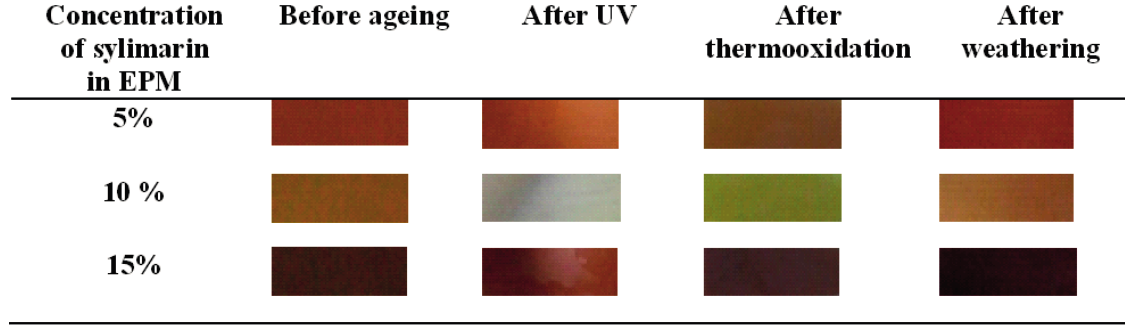
Figure 11. Image of the EPM composite containing silymarin before and after